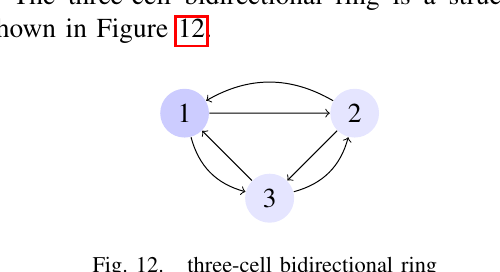
Fig. 14. Five-cell networks that admit three-cell bidirectional ring as a quotient, taken from